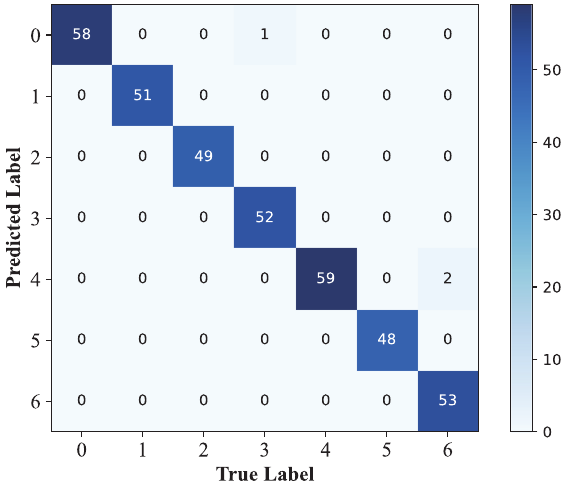
Figure 9. Confusion matrix.